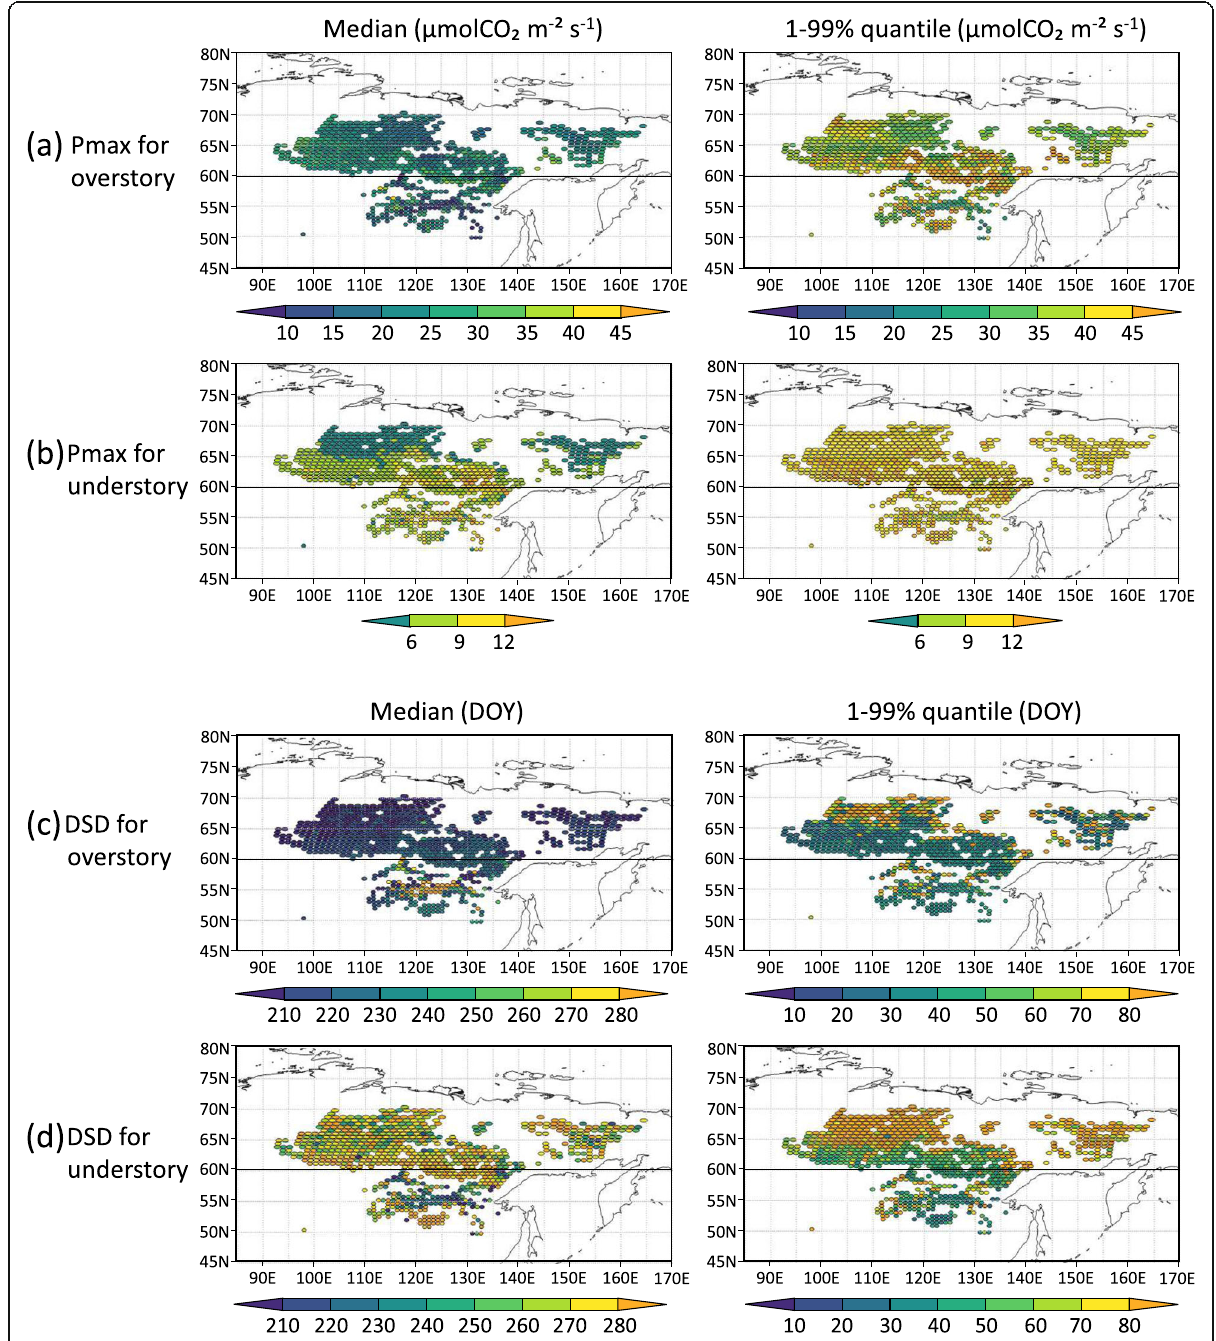
Fig. 6 Estimated parameters. Annual means of the median (left) and 1 – 99% quantile range (right) of the parameters for TEST: a maximum photosynthetic rate (Pmax) for overstory, b Pmax for understory, c defoliation start date (DSD) for overstory, and d DSD for